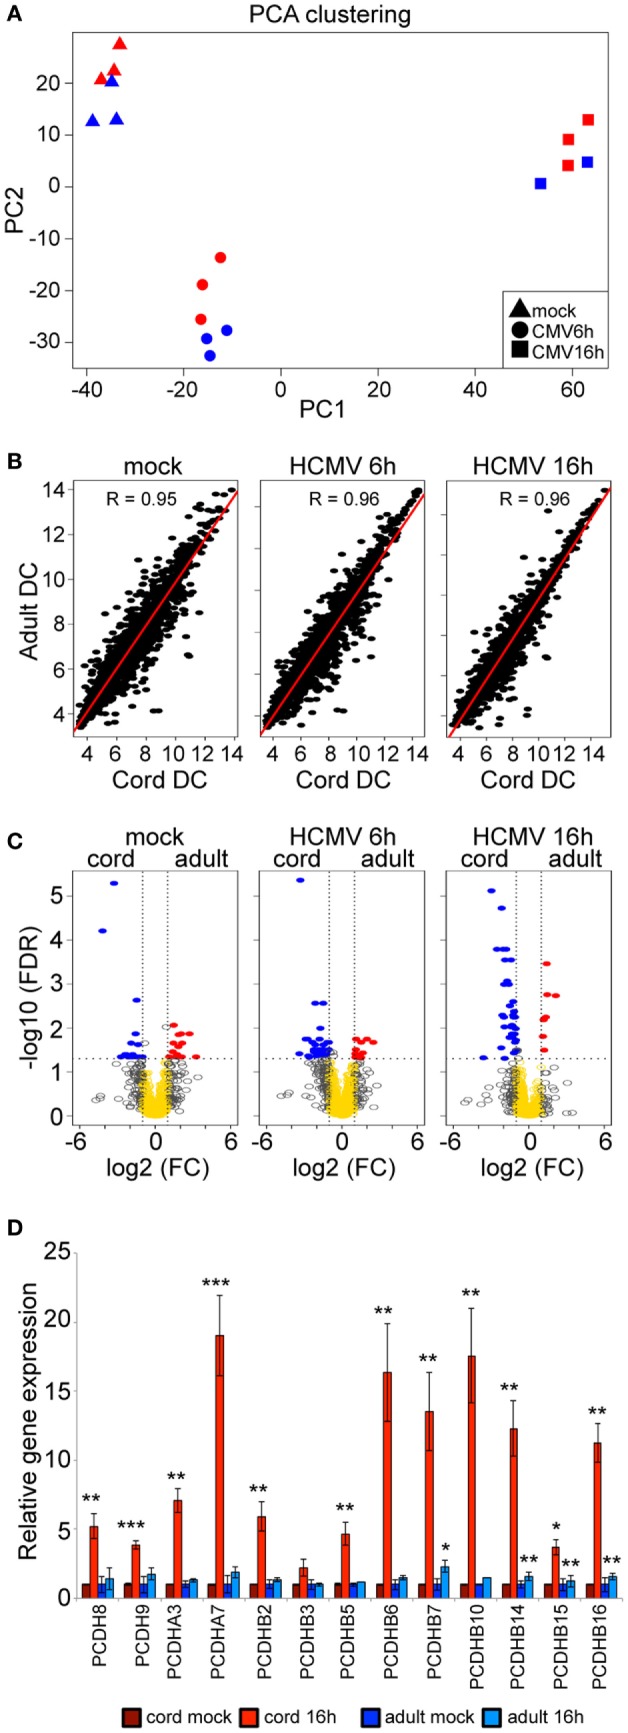
Cord and adult DCs show a high concordant genome-wide response to HCMV infection but differential expression of clustered and non-clustered PCDH genes late upon HCMV. PCA clustering over time of mean whole-genome gene expression (log2 mean expression) in mock-infected and HCMV-infected neonatal cord (red) and adult (blue) DCs (A). Regression analysis of mean whole-genome gene expression (log2 mean expression), between cord and adult DCs, show a strong correlation in mock (R = 0.95) and at 6 h (R = 0.96) and 16 h (R = 0.96) of infection (B). Volcano plots comparing log2 mean expression values of filtered genes between adults and cord DCs, after false discovery correction (−log10 FDR) (C). Fold-change expression levels of PCDH genes in cord (red bars) and adult DCs (blue bars) 16 h of HCMV infection, relative to mock-infected cord and adult DCs (set as 1) (D). The error bars indicate the SEM. Statistical significance was calculated using non-paired student t-test. *p < 0.05, **p < 0.01, and ***p < 0.001.